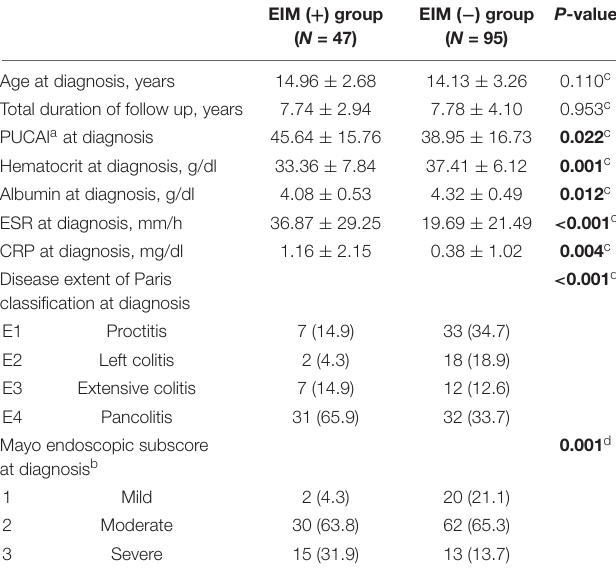
TABLE 2 | Demographic and clinical features at the time of diagnosis of the two groups; patients in EIM ( + ) group have extraintestinal manifestations with intestinal symptoms and patients in EIM ( − ) group only express intestinal